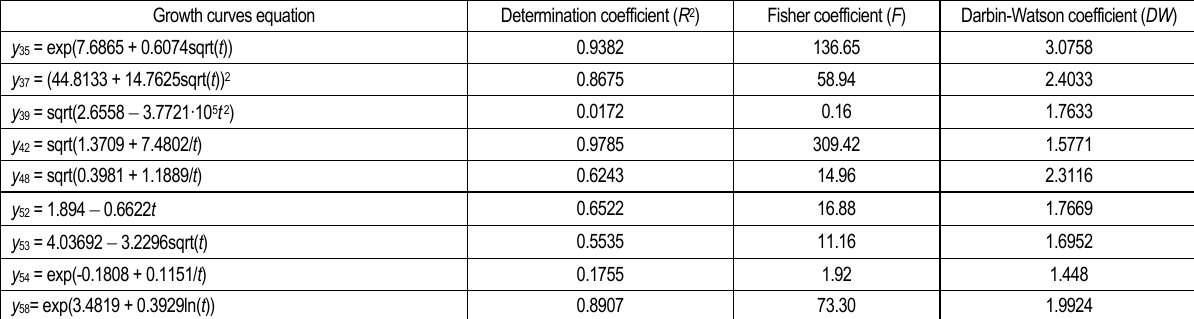
Table 9 (cont.). Growth curves equations of socioeconomic development indexes of Ukraine Growth curves equation